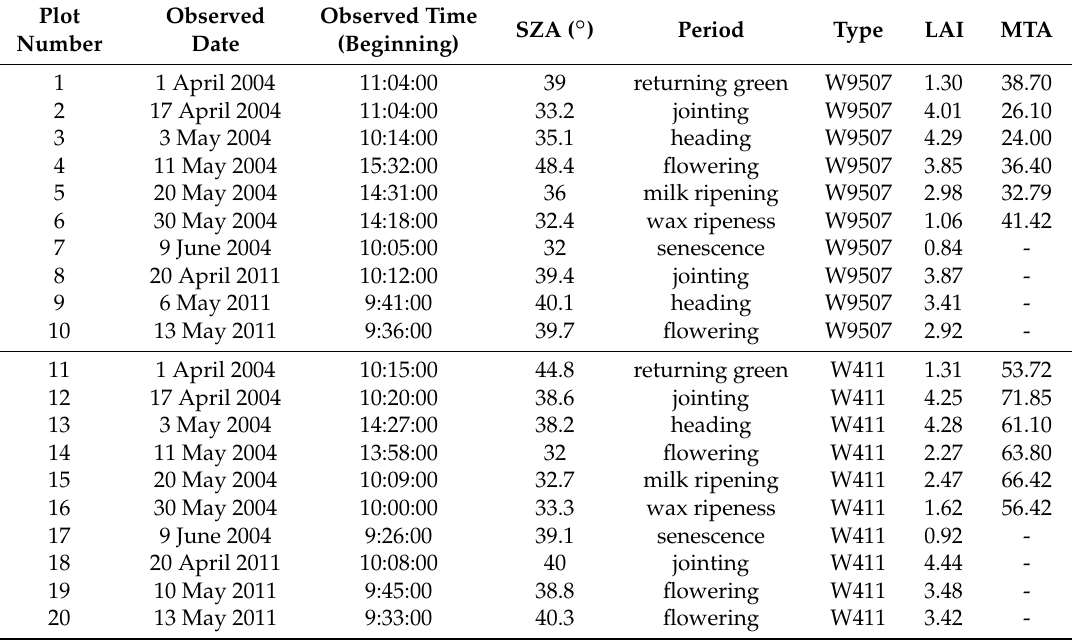
Table 1. Precise information of each